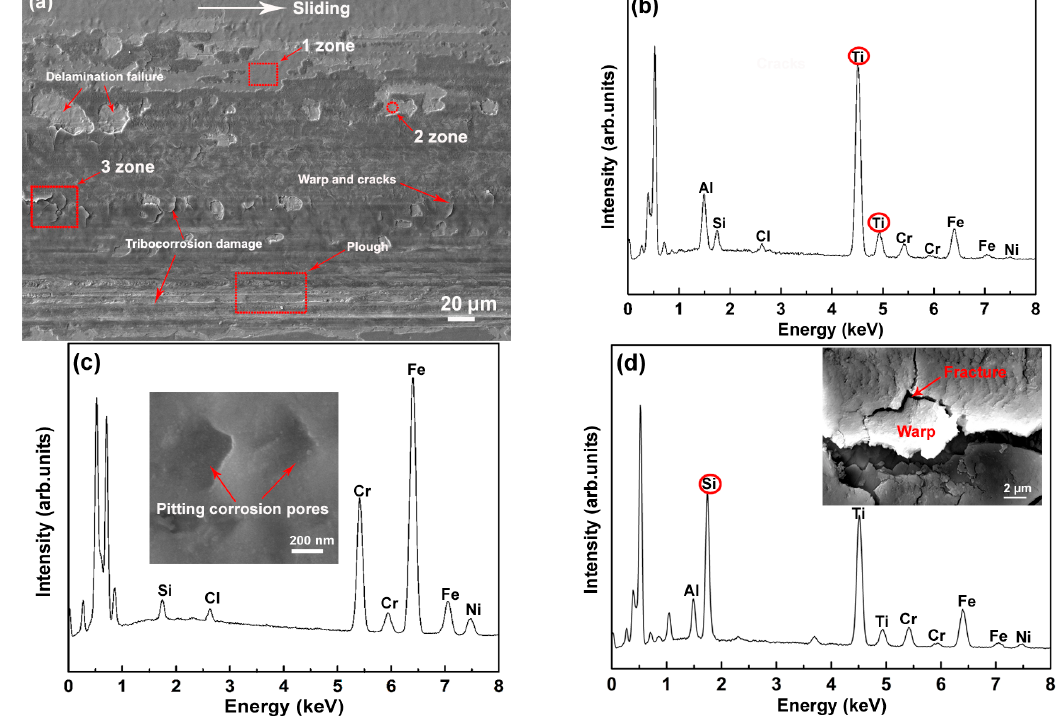
Figure 11. ( a ) SEM images of wear track in TiN/SiO x duplex coating in NaCl solution; ( b ) EDS analysis of zone 1; ( c ) EDS analysis of zone 2; ( d ) EDS analysis of zone 3.